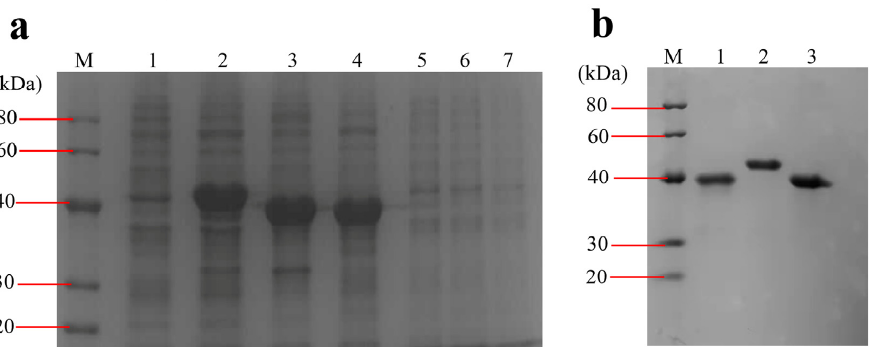
Figure 2. Expression and purification of the OMPs. ( a ) Expression of the OMPs. Lane M, protein marker (20–40 kDa); lane 1, total proteins of BL21 harboring pET28a vector induced by IPTG; lane 2–4, total proteins of BL21 harboring pET28a-bamA, pET28a-ompA, pET28a-ompC induced by IPTG, respectively; lanes 5–7, total proteins of BL21 harboring pET28a-bamA, pET28a-ompA, pET28a-ompC without being induced by IPTG, respectively. ( b ) Purified OMPs. Lane 1–3, eluent of the purified rOmpA, rBamA, rOmpC,